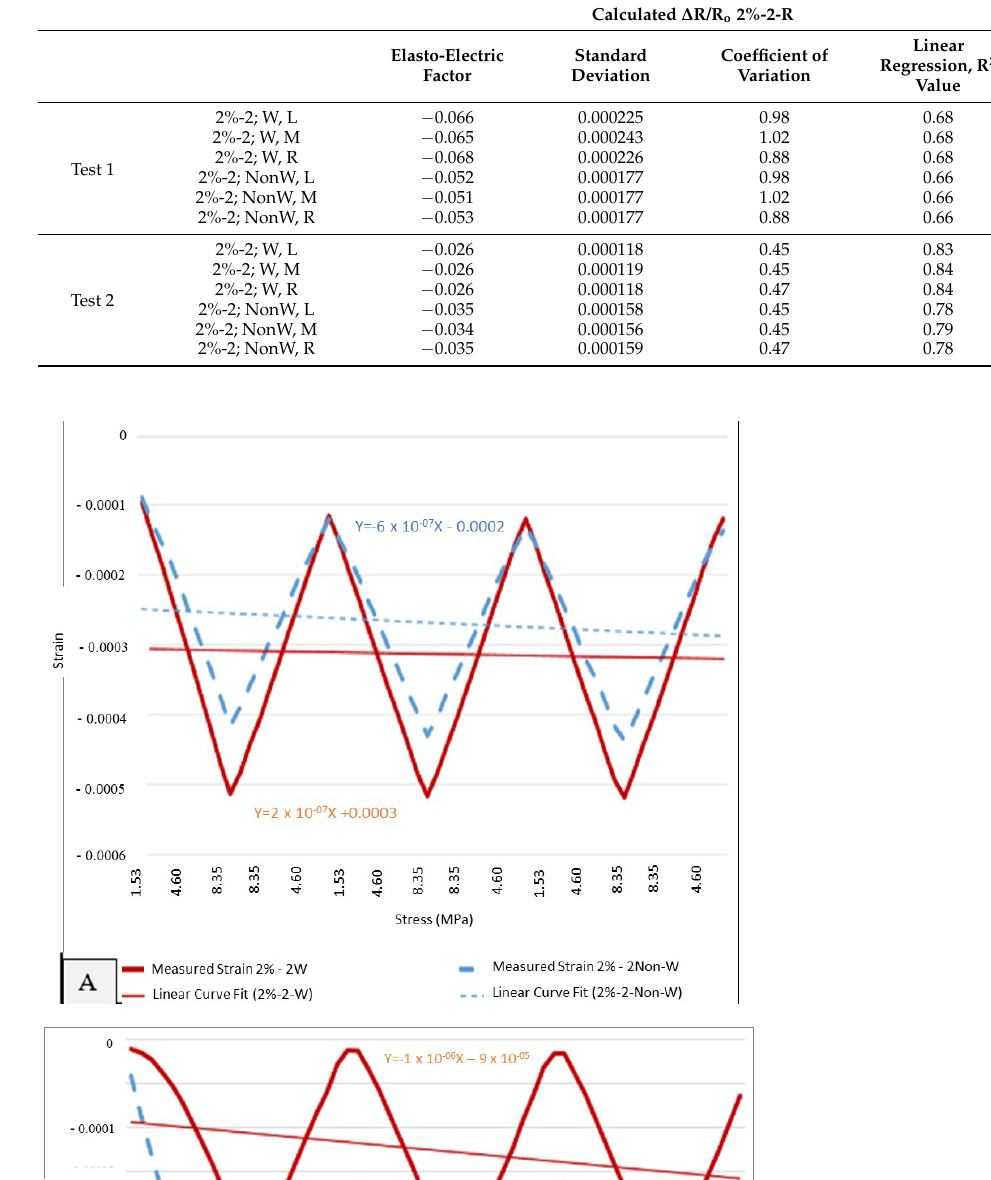
Table 4. Statistical Comparisons between Test 1 and Test 2 for 2% Specimen.